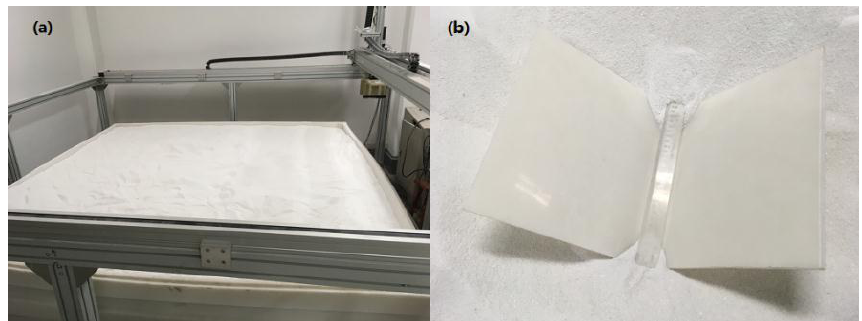
Figure 8. The sand trough ( a ) and the target body ( b ).